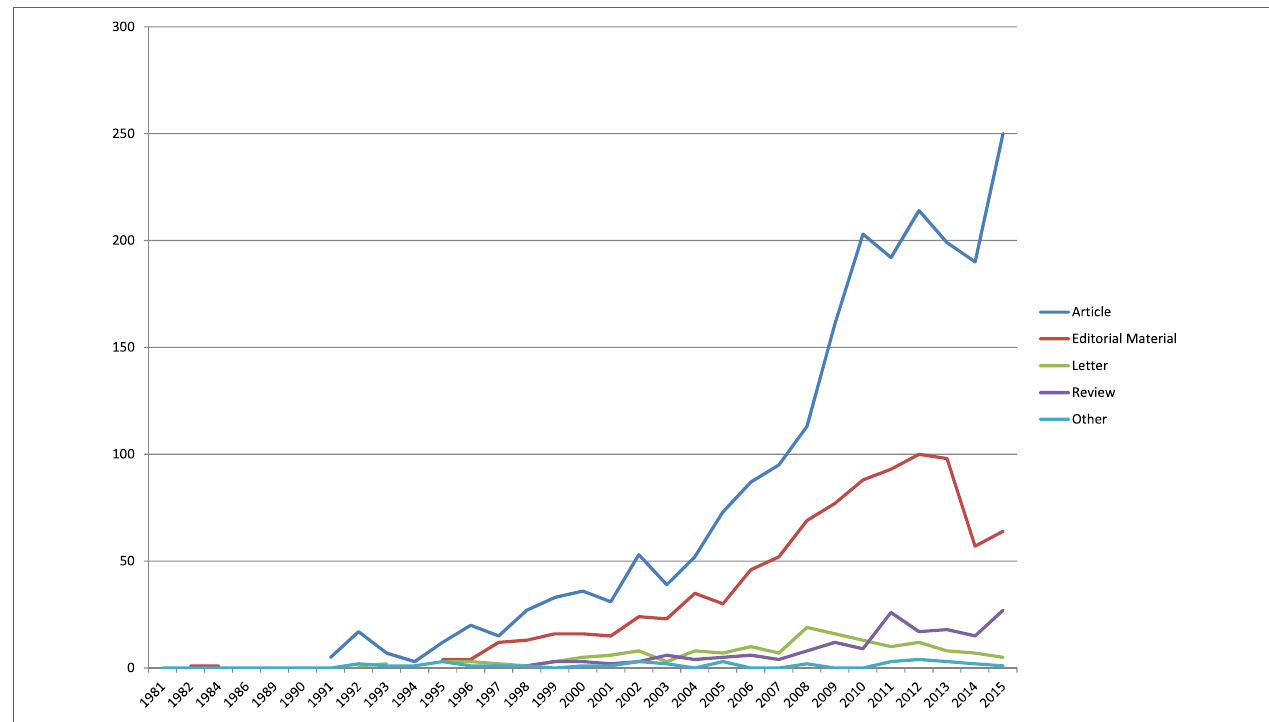
FigUre 2 | Trend analysis of output in Wos on Journal impact Factors across various document types, 1981–2015